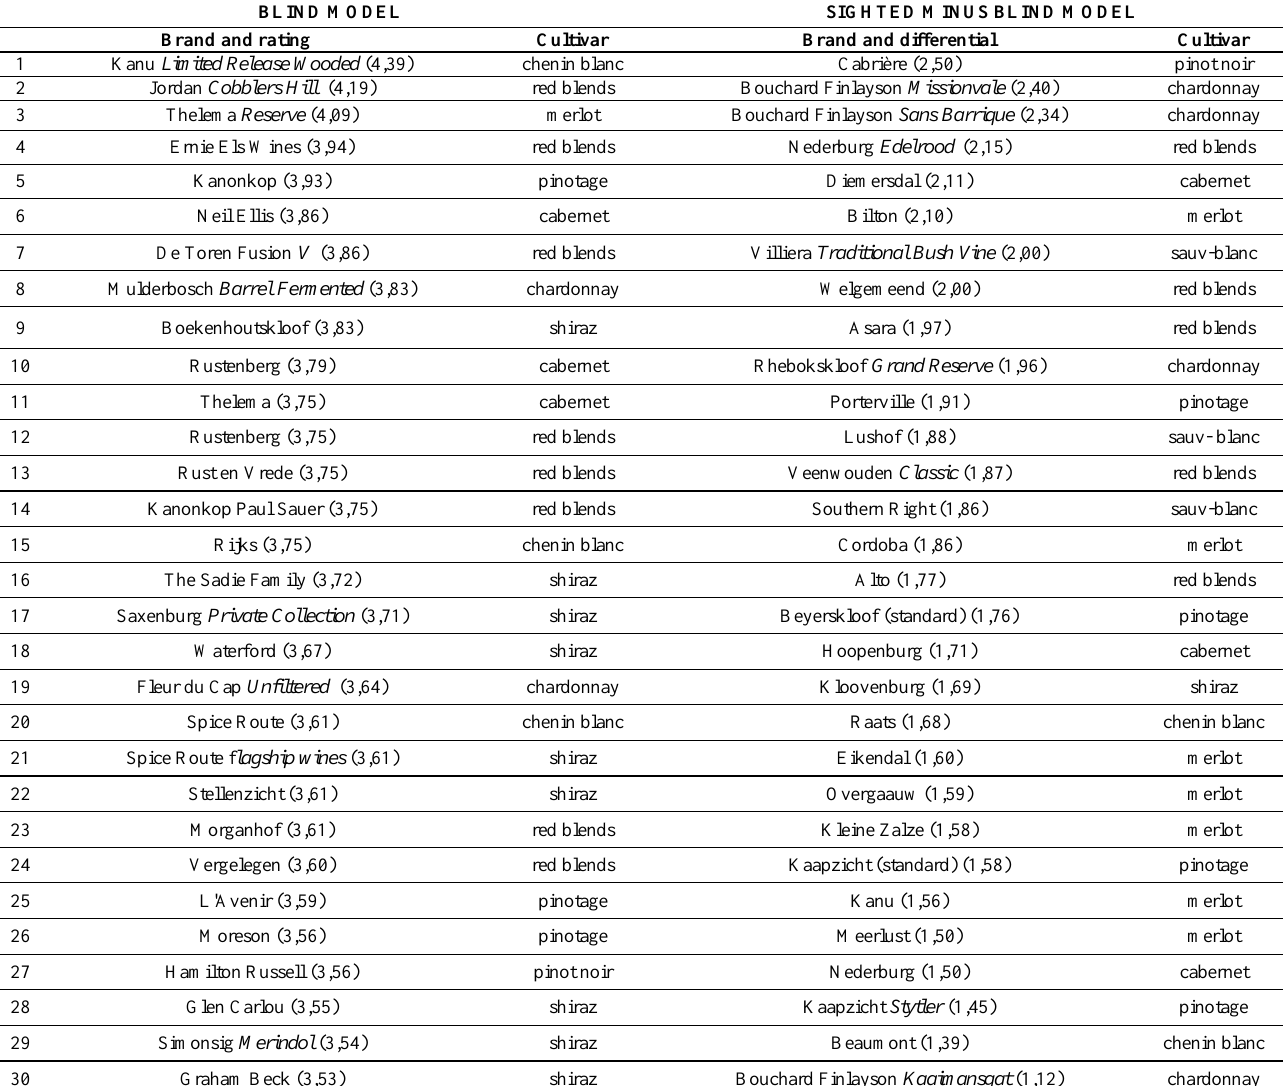
Table 1: The top 30 brand effects identified for blind and sighted-to-blind assessments. This replicates Table 12 in Priilaid and van Rensburg, 2010a. Ratings (in parenthesis) for the blind and sighted-to-blind models are fitted values and are derived in Priilaid and Van Rensburg (2010a). Respectively, they should be noted in relation to the broader blind and sighted-to-blind score means of 2,59 and 0,92.